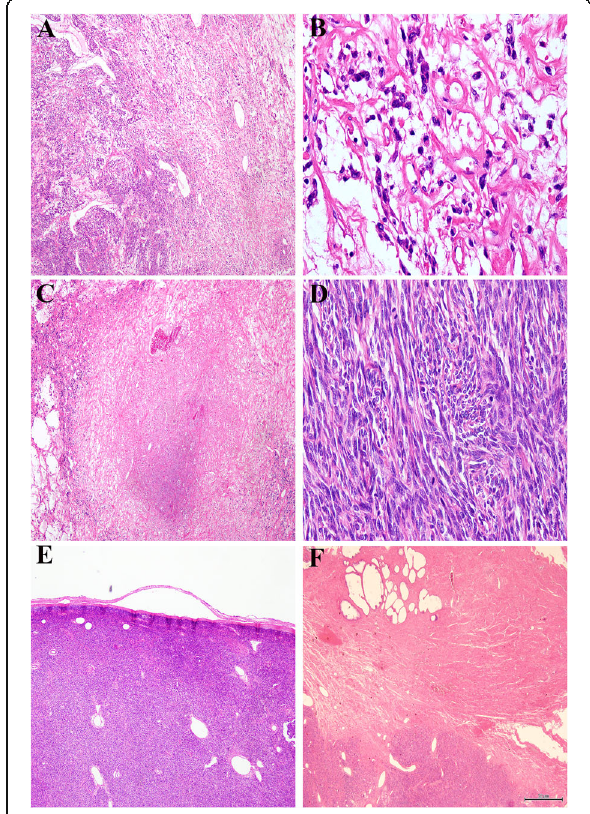
Fig. 2 Histological features of the neoplasm. ( a alternating hypocellular and hypercellular areas; b hypocellular area with a patternless population of ovoid cells with bland nuclear features; c area of necrosis; d hypercellular area with short compact fascicles of spindle cells with moderately atypical nuclei and some evident mitotic figures; e well-demarcated border; f infiltrating behavior in proximity to the right seminal